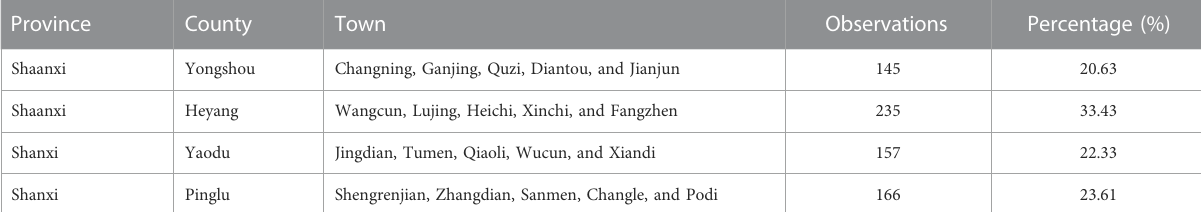
TABLE 4 Distribution of